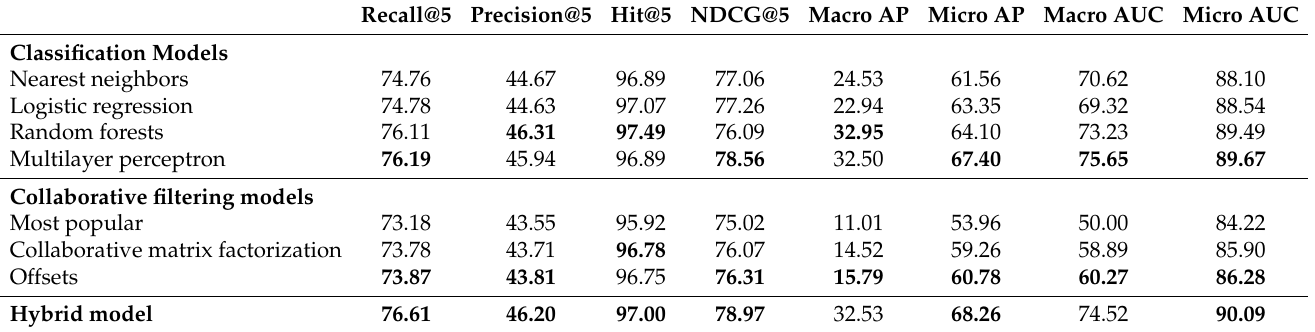
Table 2. Performance of the classification, collaborative filtering, and hybrid models for recommend- ing drugs on the test